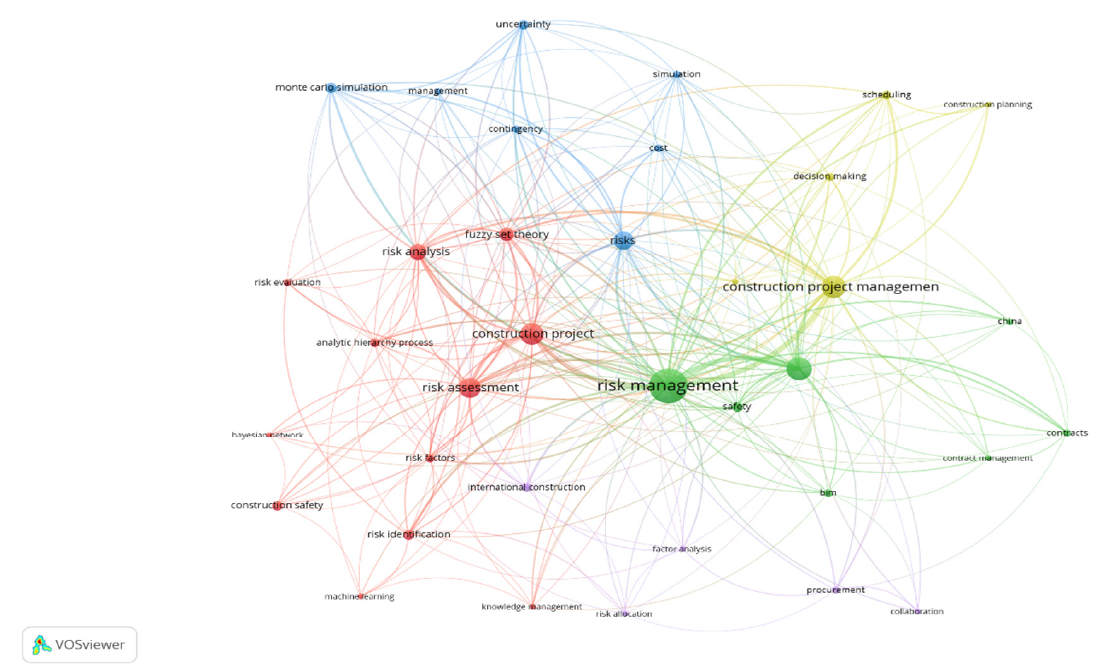
Figure 7. Network diagram of author keywords.